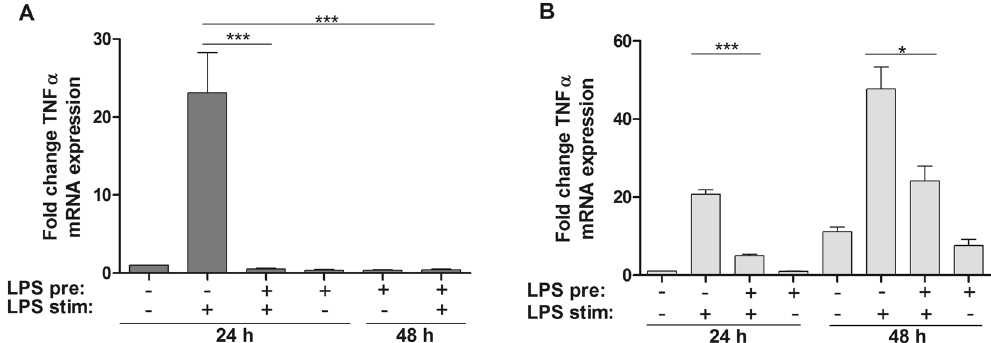
Figure 1. TNF α mRNA expression in naïve and LPS-reprogrammed monocytes indicates tolerance. Monocytes ( A ) and THP-1 cells ( B ) were pretreated for 24 or 48 h with fresh medium or 50 ng/ml LPS in fresh medium, washed, and either left untreated or re-challenged with 50 ng/ml LPS for 2 h. RNA was isolated, reversed transcribed, and analyzed by RT-qPCR. Shown are fold changes of TNF α mRNA production normalized to the house-keeping gene PPIB and compared to unstimulated control samples (mean of three independent experiments (THP-1) or three independent donors (monocytes) ± SE). *** p ≤ 0.001, * p ≤